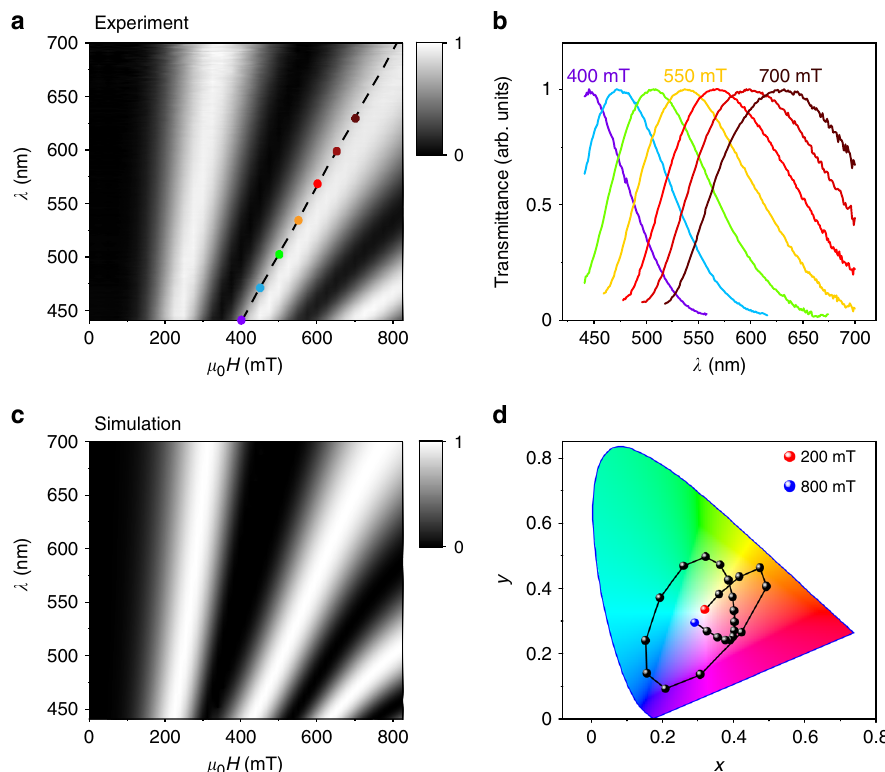
Fig. 3 Magnetic fi eld-dependent transmission of light through the CTO suspension at different wavelengths. a Experimental map of the normalised transmittance as a function of λ and H . The light transmission was measured using the setup with crossed polarisers as shown in Fig. 1a. Grey scale: black for zero intensity and white for the maximum intensity. b Red shift of the constructive interference wavelength λ c (corresponding to transmittance maxima) with H . The wavelength maxima for the colour-coded spectra correspond to the coloured dots in a . c Simulation of the transmitted light intensity based on our statistical model of magnetic- fi eld-induced birefringence (see text). Grey scale: black for zero intensity and white for the maximum intensity. Bright and dark stripes correspond to δ ( H, λ ) = (2 N − 1) π and (2 N − 2) π , respectively ( N = 1, 2, 3). d Coordinate evolution of transmittance spectrum in a during continuous increasing of magnetic fi eld from 200 mT to 800 mT with a 25 mT step, presented at a standard CIE xy 1931 colour space (CIE, International Commission on Illumination).